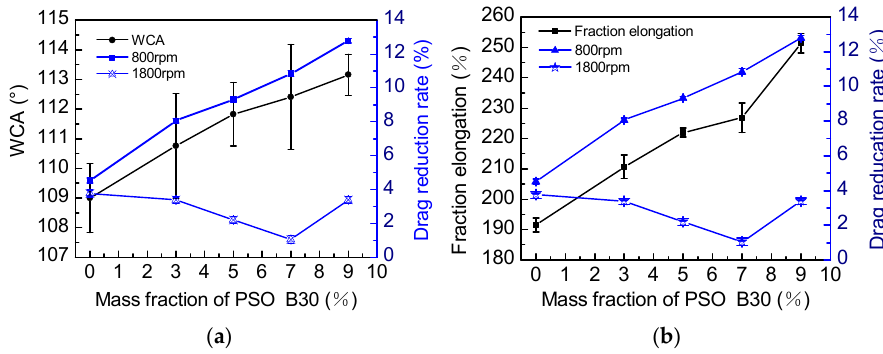
Figure 11. ( a ) The influence of the addition amount of PSO on WCA and drag reduction rate, ( b ) the influence of the addition amount of PSO on fraction elongation and drag reduction rate.